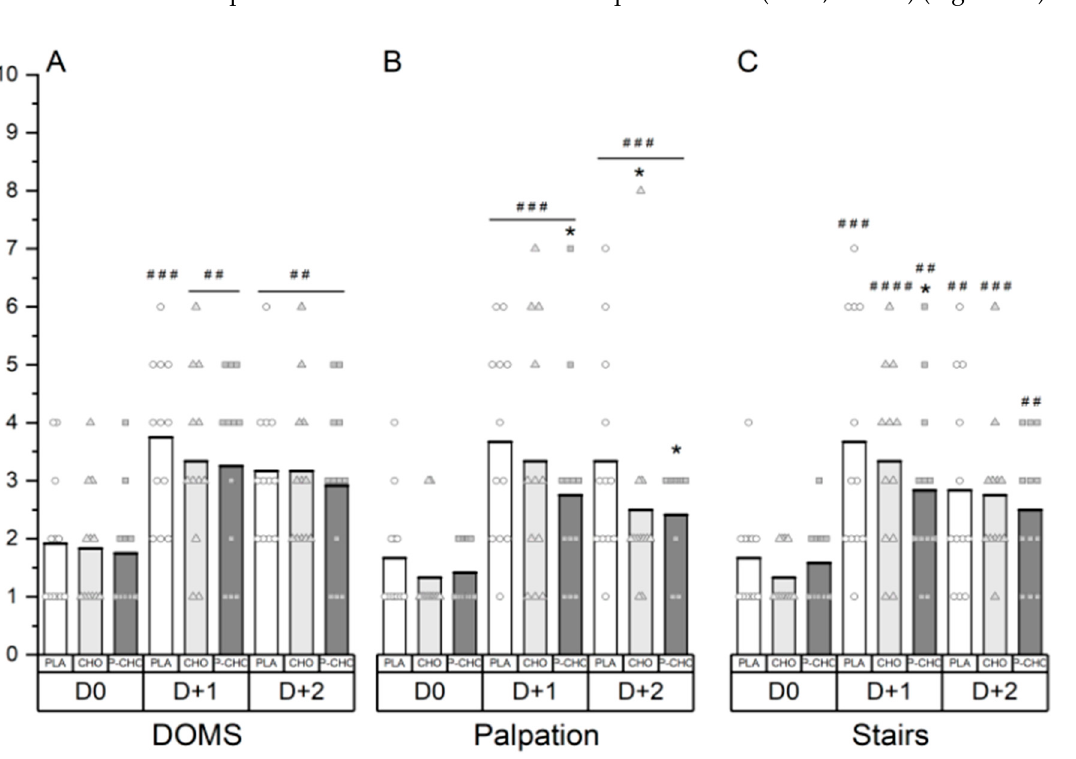
Figure 4. Muscle pain scores in general ( A ), at leg palpation ( B ) and when descending stairs ( C ). D0 for PRE situation; D + 1, 24 h after exercise and D + 2, 48 h after exercise. * denotes a difference compared to PLA ( small ). ## denotes a difference compared to D0 ( moderate) . ### , large . #### , very large .